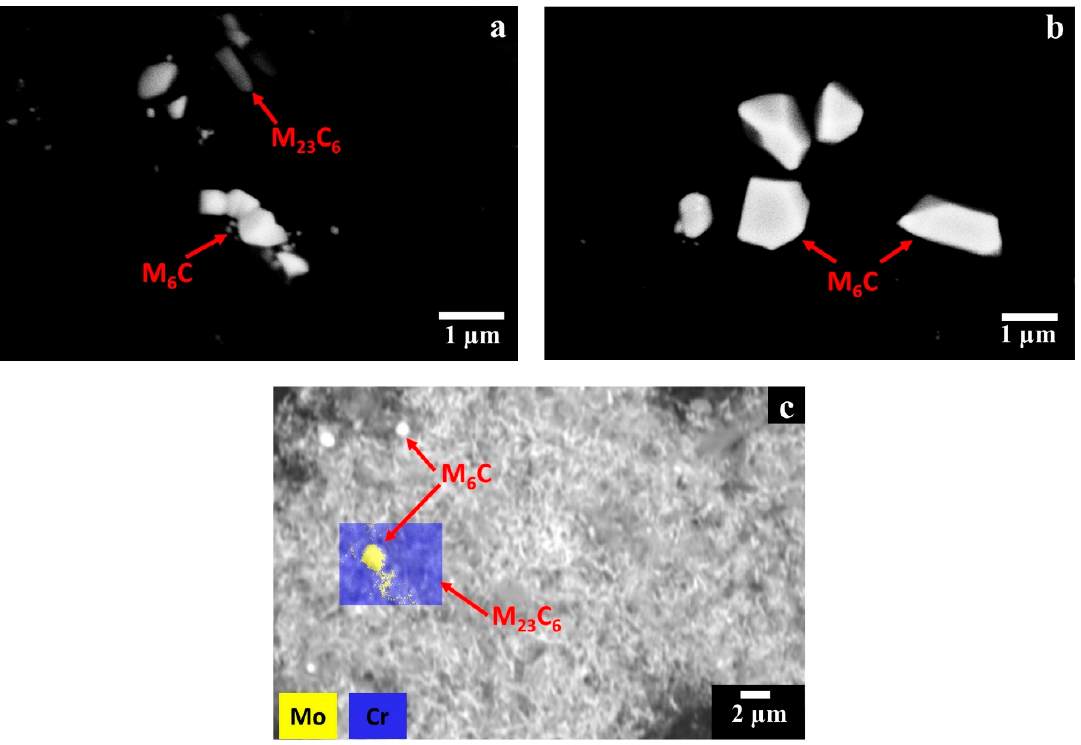
Figure 6. BSE SEM images of the extracted carbides within the post-processed HX states: ( a ) HIPed state showing M 6 C and M 23 C 6 carbides; ( b ) post-solution annealed state revealing M 6 C carbides; ( c ) HT state exhibiting filaments of Cr-rich M 23 C 6 carbides with the presence of few Mo-rich M 6 C carbides.